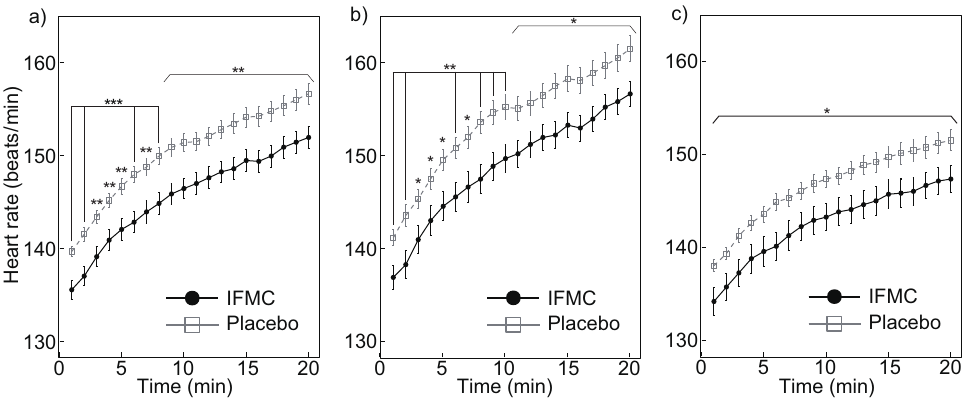
Figure 3. Differences in ( a ) all, ( b ) male, and ( c ) female heart rate over 20 min between IFMC and placebo applications. The symbols *, **, and *** stand for significant difference between IFMC and Placebo groups at p < 0.05, p < 0.01, and p < 0.001,